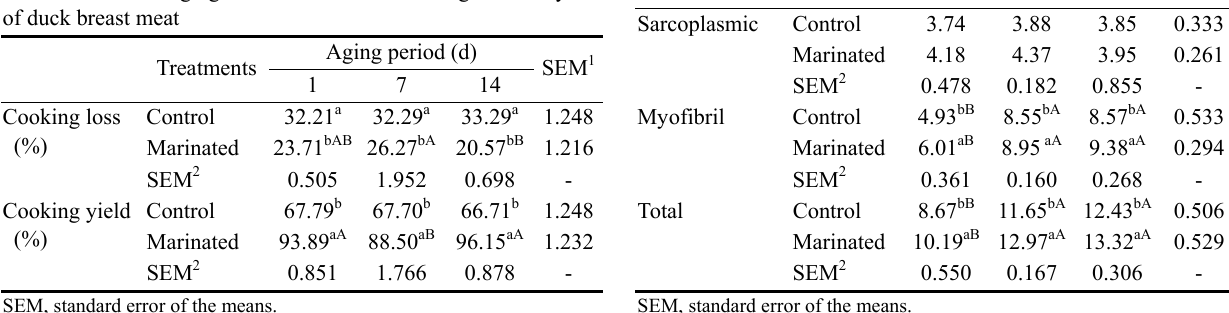
SEM, standard error of the means. 1 n = 9. 2 n =